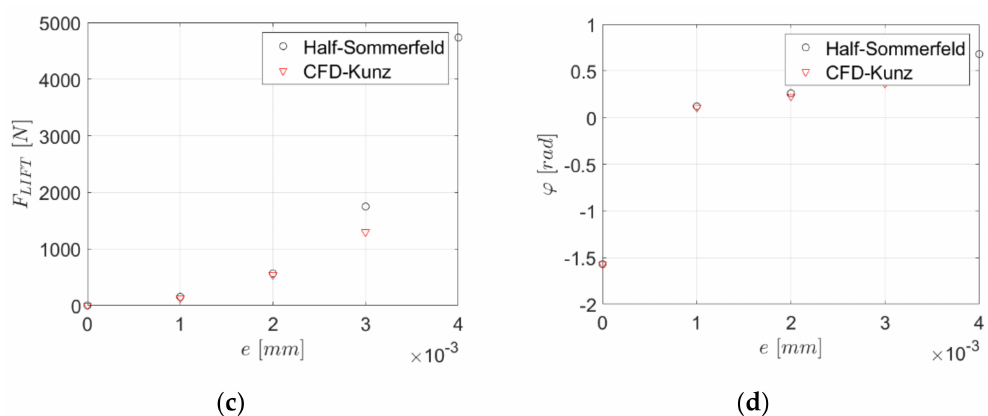
Figure 6. Total hydraulic force ( a ); Drag (F ⊥ ) force ( b ); Lift (F || ) force ( c ) and attitude angle ( d ) vs. eccentricity; –1500 rad / s.